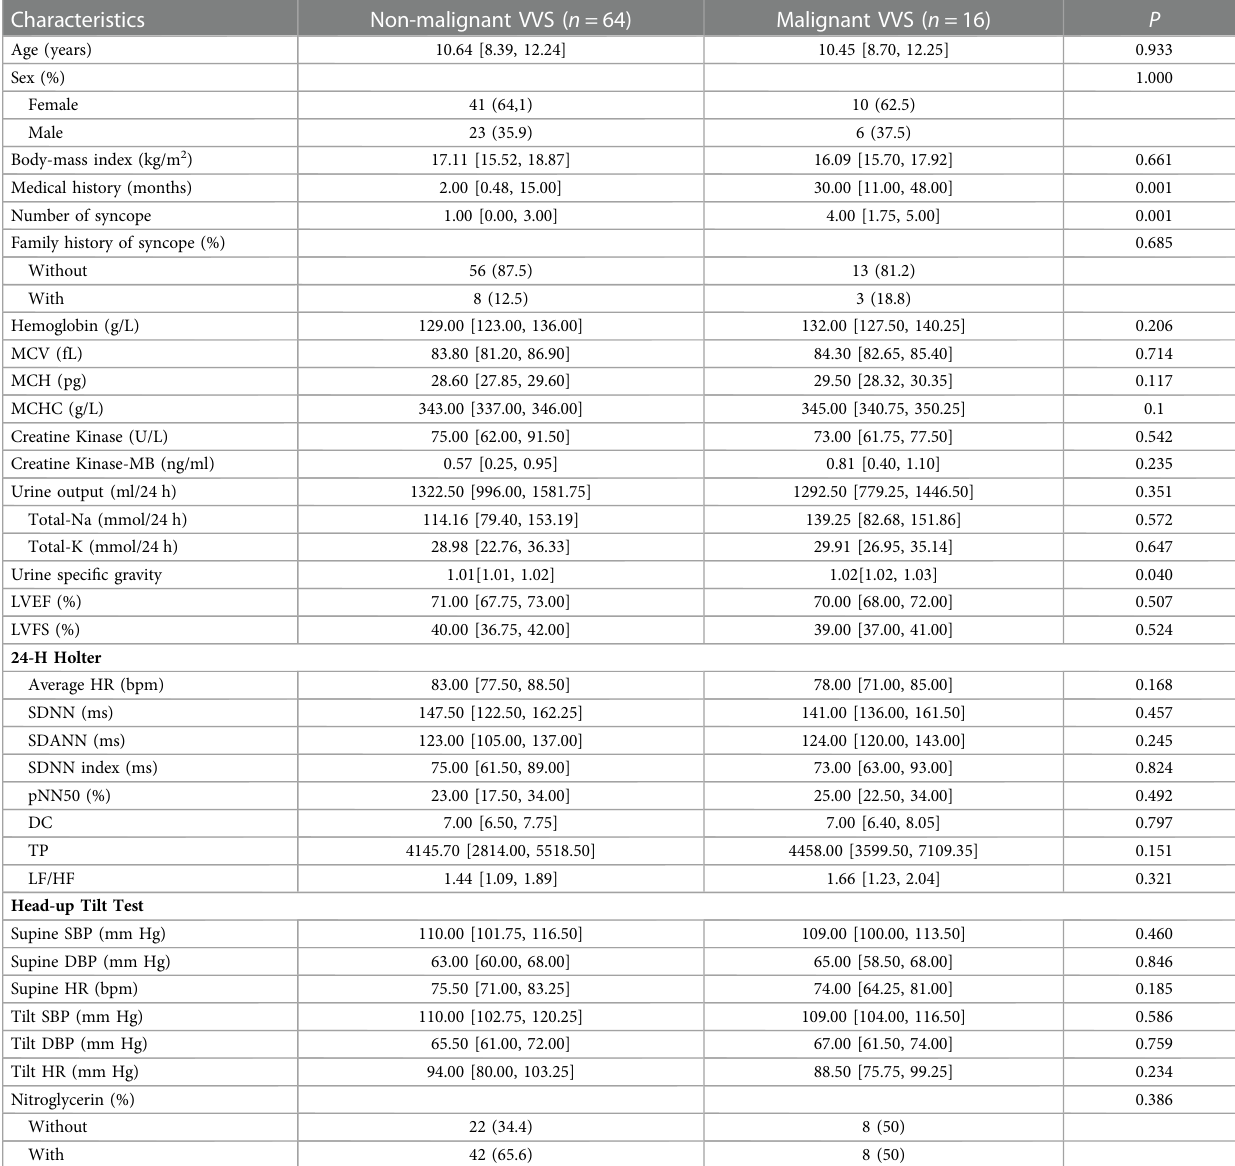
TABLE 1 Baseline characteristics of study children after propensity score matching.